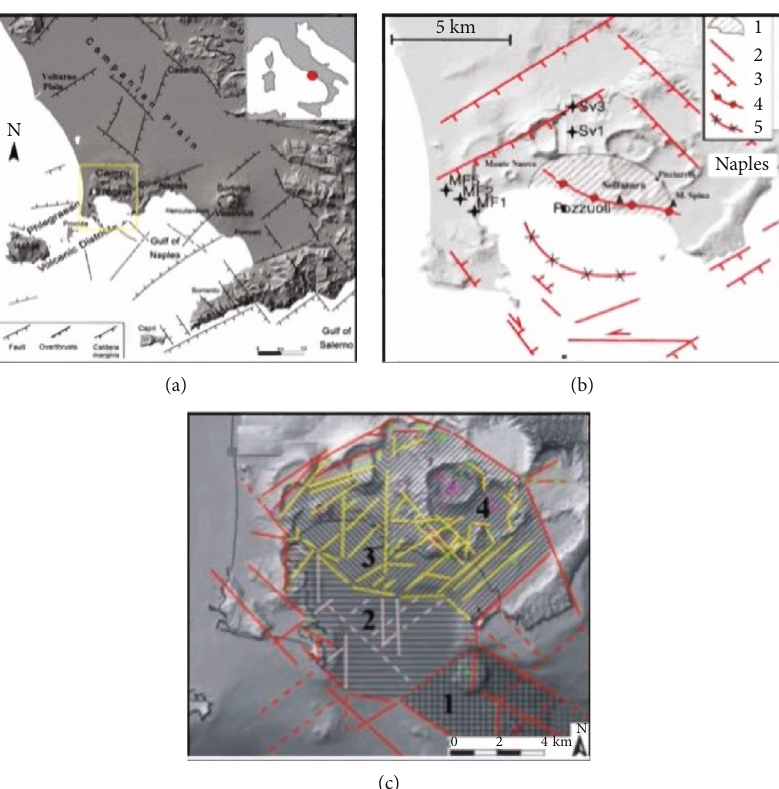
Figure 1: (a) Structural sketch map of the Campanian Plain and surrounding Apennines. (b) Structural map of the CF – Pozzuoli Bay area: (1) area a ff ected by an uplift of 100 – 50% during the 1982 – 84 bradyseism; (2) fractures and lateral faults; (3) normal faults; (4) Pozzuoli anticline; (5) Pozzuoli Bay syncline. Black stars geothermal wells: MF =Mofete; SV =San Vito (from Milia et al. [17]; Milia and Torrente [18]). (c) Structural sketch map of CF caldera: (1) sector deformed during caldera collapse; (2) undeformed to subsiding portion of the caldera fl oor; (3) eastern sector of the resurgent portion of the caldera fl oor; (4) western sector of the resurgent portion of the caldera fl oor; red lines=regional faults activated during caldera collapse; yellow lines=regional faults reactivated during resurgence of a portion of the caldera fl oor; white lines=regional faults reactivated during subsidence of a portion of the caldera fl oor (modi fi ed from Capuano et al.